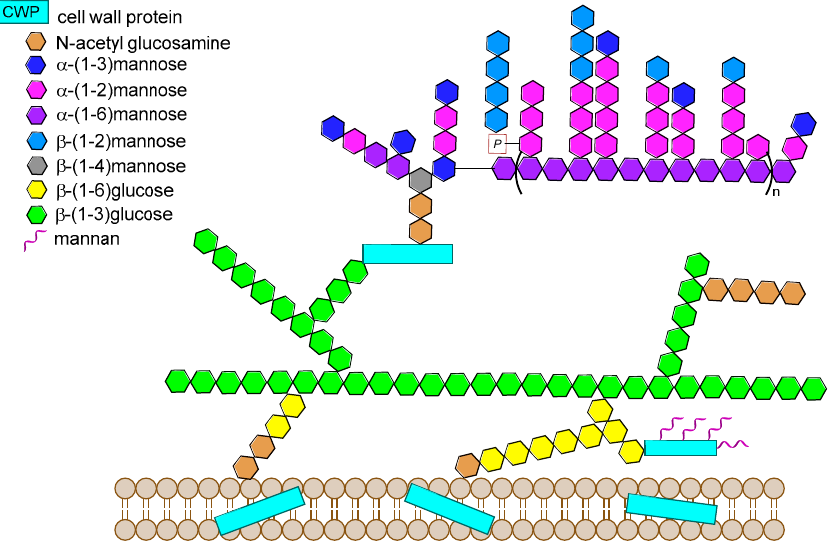
Figure 31. Major components of C. Albicans cell wall: β -(1,3)-glucan and chitin (poly- β -(1,4)- N -acetylglucosamine) are the main components of inner cell wall. The outer layer is enriched with polymannans.